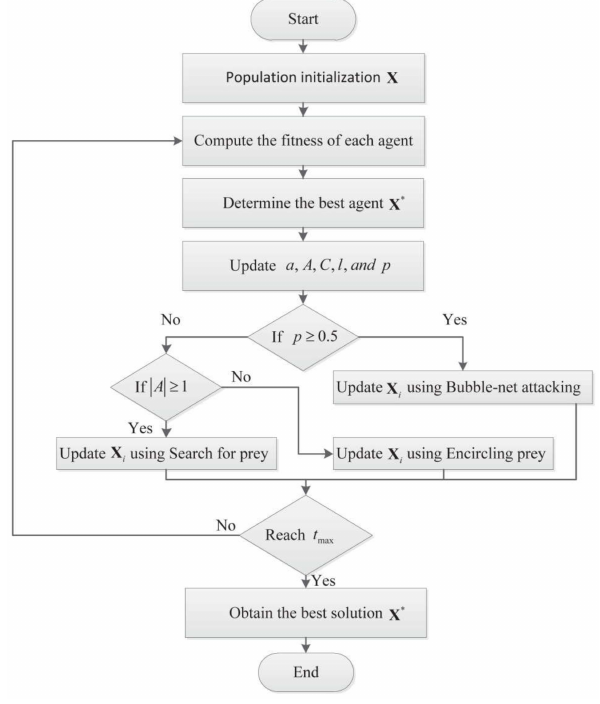
Figure 1. The flow diagram of